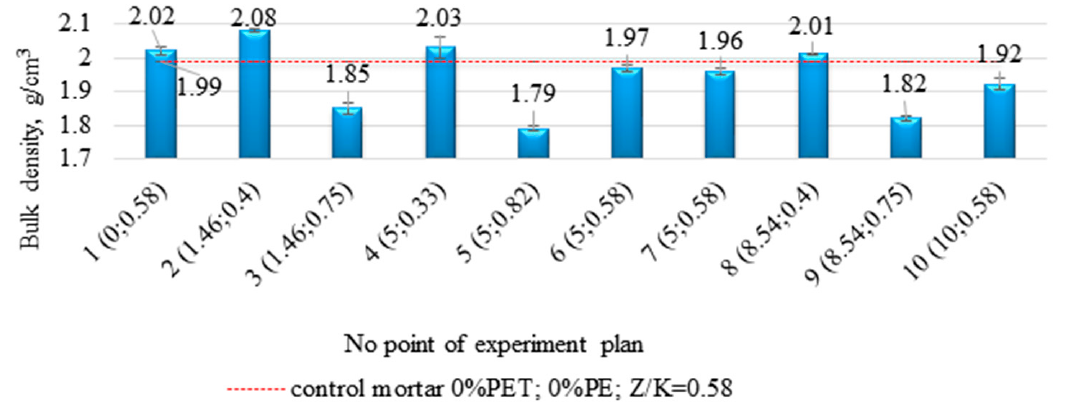
Figure 15. The compilation of mean volumetric density values calculated for each point of the experimental plan. It can be seen from Figure 16a,b that an increase in the proportion of resin and PE waste content in the epoxy composites reduces the bulk density of these